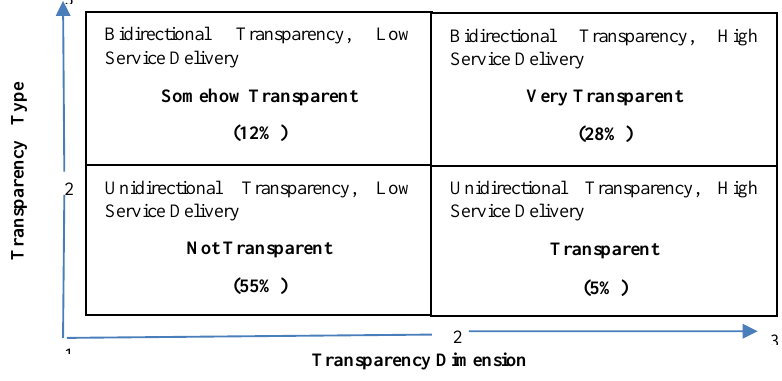
Figure 5: Typology of Direction Transparency and Service Delivery